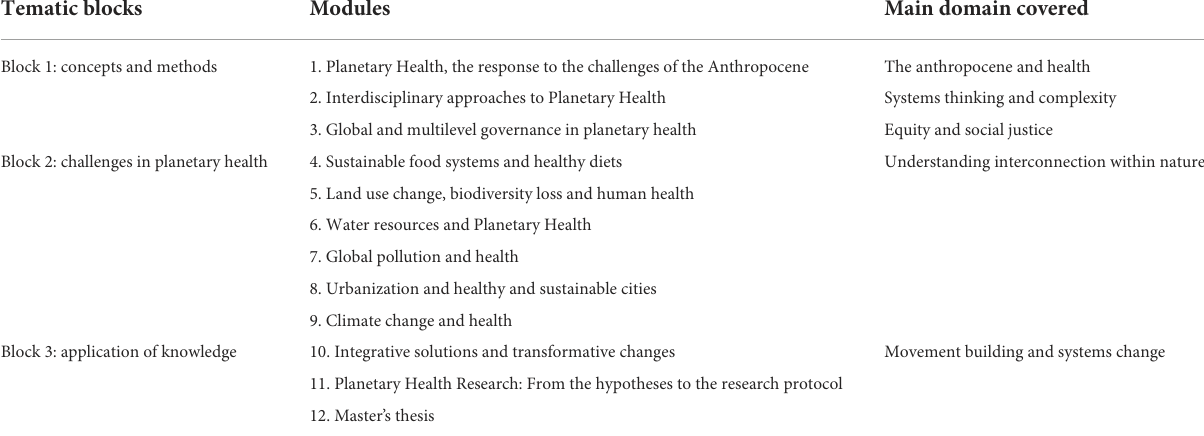
TABLE 1 Organization of the MSc in Planetary Health in relation to the domains defined in the Planetary Health educational framework (18). Tematic blocks